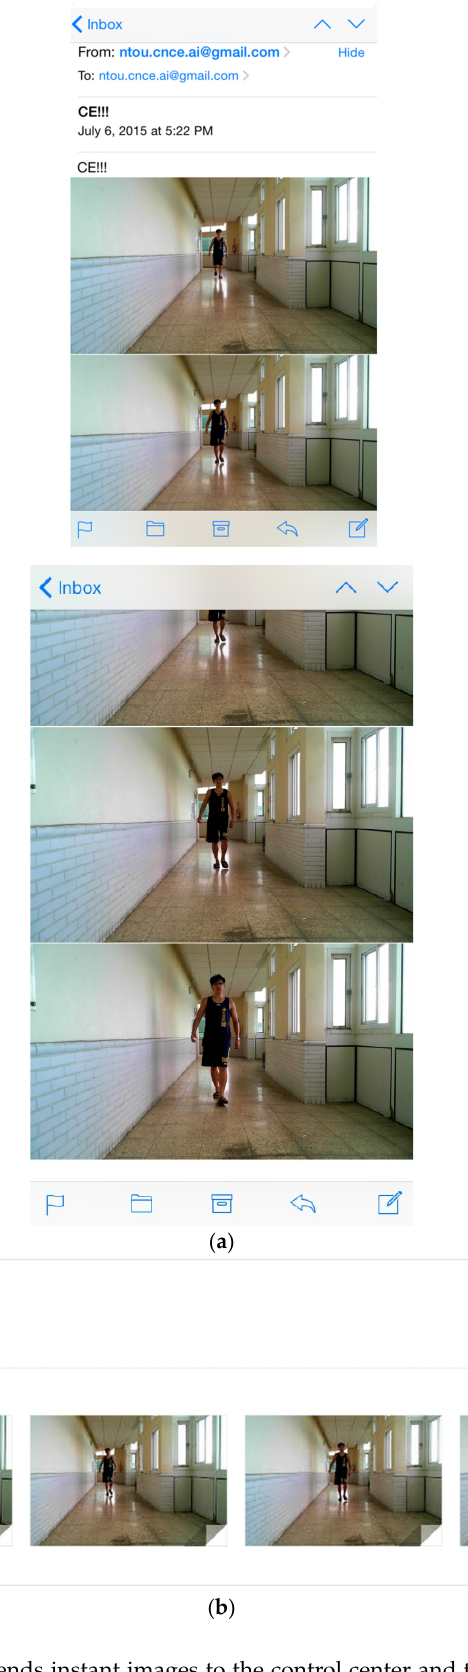
Figure 31. Communication sequence.